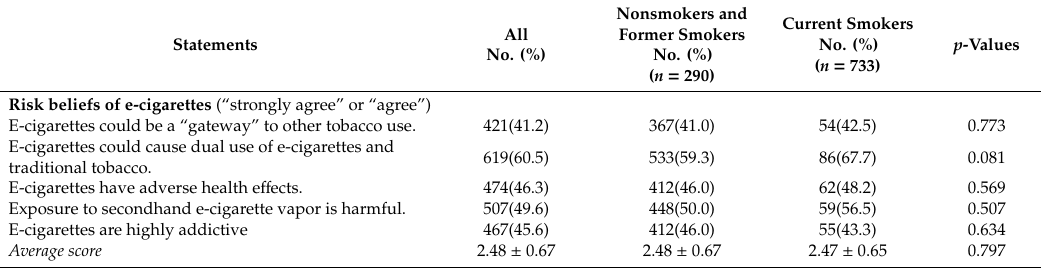
Table 2. Risk beliefs, attitudes, and confidence to deliver e-cigarette counseling among 1023 Chinese